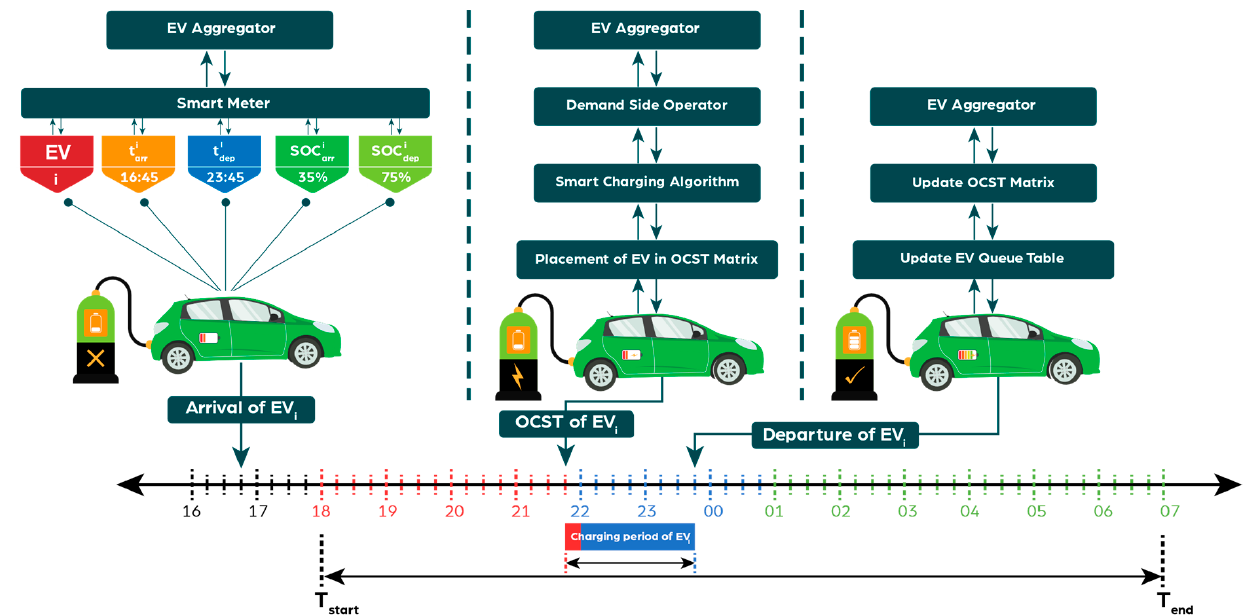
Figure 2. General layout of coordinated charging process for an electric vehicle.